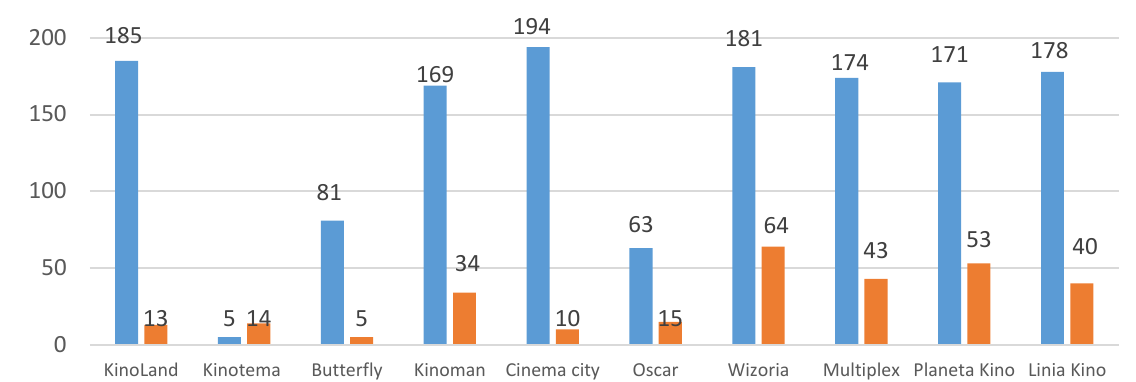
Number of posts on Facebook from March 12 to July 2 in 2019 Figure 2. Number of posts on the official pages of cinema networks on Facebook for the same periods in 2019 and 2020